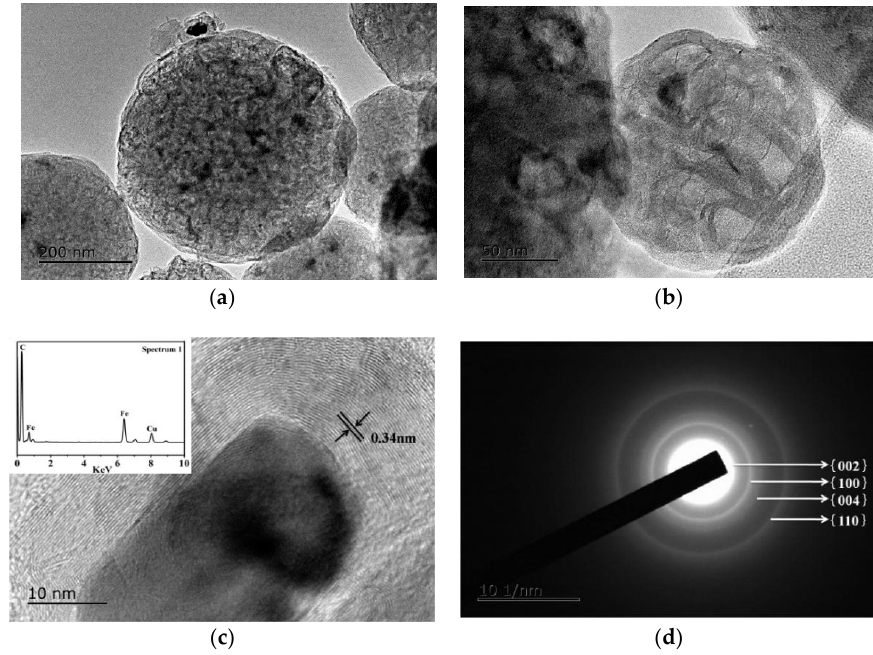
Figure 9. TEM ( a ), HRTEM images ( b ), selected-are electron diffraction (SAED) ( c ), and energy dispersive spectrometer (EDS) ( d ) of HGCS prepared at 900 °C for 3 h with 1.0 wt % Fe catalyst.